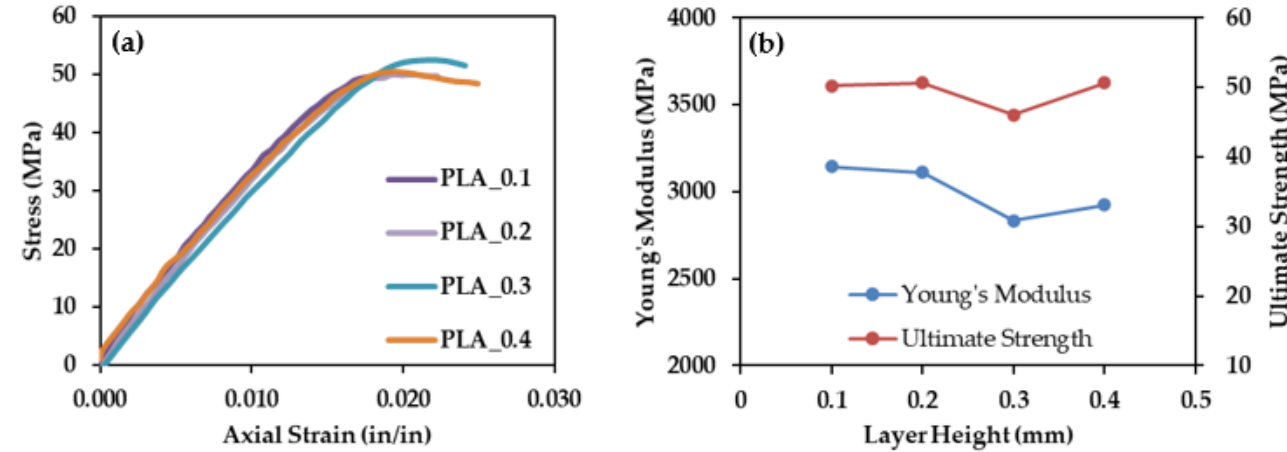
Figure 10. ( a ) Average tensile response and ( b ) Young’s modulus and Ultimate Strength for PLA printed at 0.1, 0.2, 0.3, and 0.4 mm print layer heights.